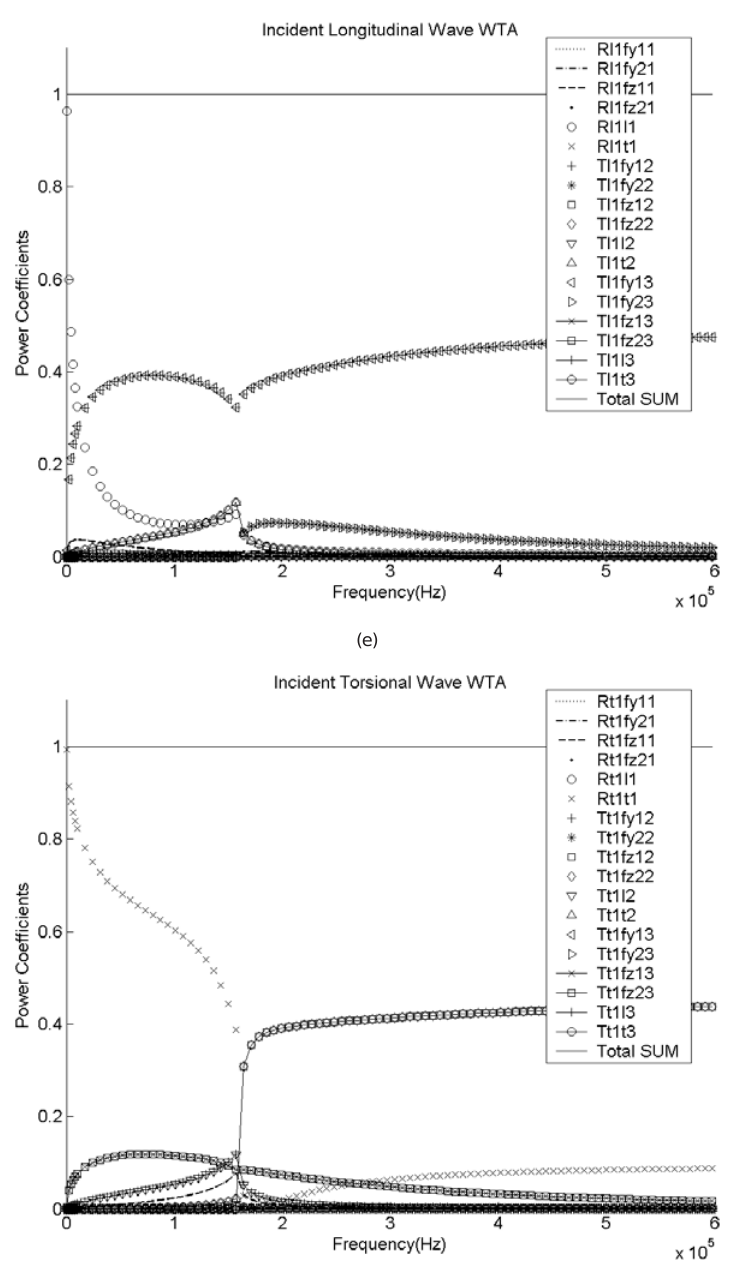
Fig. 9, continued. The power transmission and reflection coefficients of three semi-infinite Timoshenko beams with the same material and geometrical properties joined at 90 ◦ : (a) Case of the incident y-directional flexural wave with wavenumber k 1 y , (b) Case of the incident y-directional flexural wave with wavenumber k 2 y , (c) Case of the incident z-directional flexural wave with wavenumber k 1 z , (d) Case of the incident z-directional flexural wave with wavenumber k 2 z , (e) Case of the incident longitudinal wave, (f) Case of the incident torsional wave.